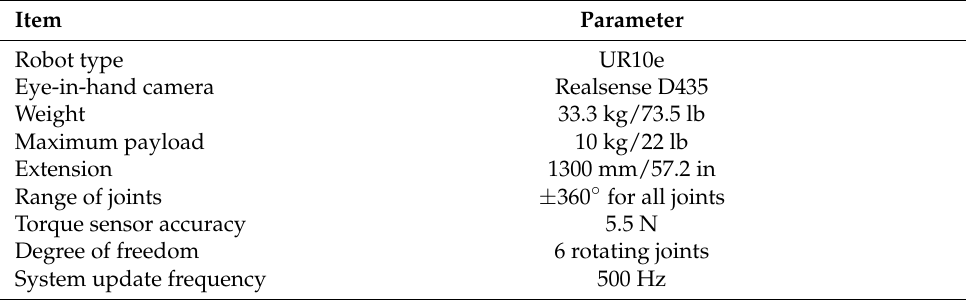
Table 1. Information on some parameters of the robotic